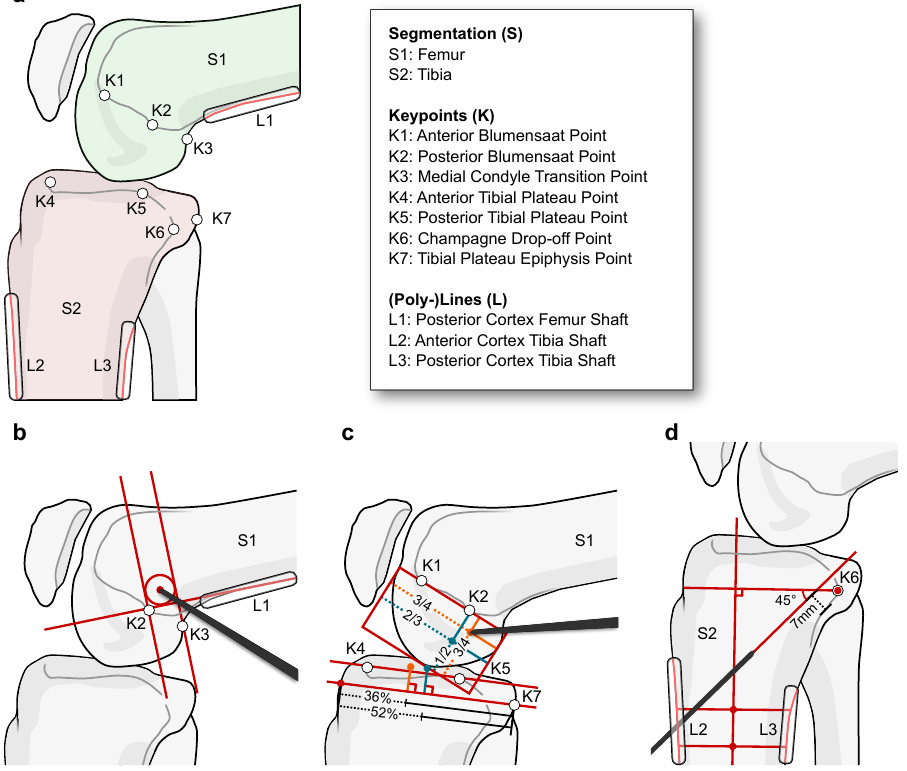
Figure 1. Illustration of the three considered surgical planning guidelines for ligament reconstruction on the knee joint. ( a ) Description and localization of relevant anatomical structures for all plannings. ( b ) Localization of the anatomic femoral insertion site for Medial Patellofemoral Ligament (MPFL) reconstruction surgery. The construction builds upon the clinical study by Schoettle et al. [21]. ( c ) Identification of the surface attachment points for the anteromedial (AM; orange) and posterolateral (PL; teal) bundles for Anterior Cruciate Ligament (ACL) reconstruction surgery. The planning follows the quadrant method by Bernard et al. [32] and Stäubli/Rauschning [34] for the femur and tibia, respectively. ( d ) Detection of the optimal drill path angulation and position for transtibial reconstruction of the Posterior Cruciate Ligament (PCL) according to Johannsen et al.